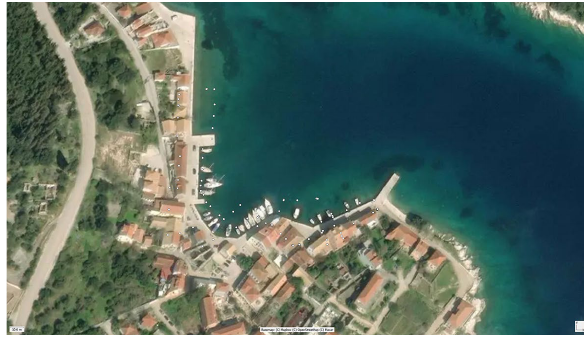
Figure 23 . Fiskardo Port,